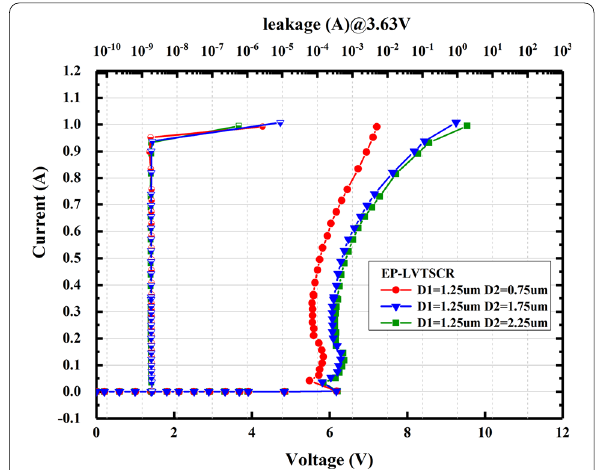
Fig. 5 Measured TLP I–V and leakage currents of EP-LVTSCR and the conventional LVTSCR with same die area